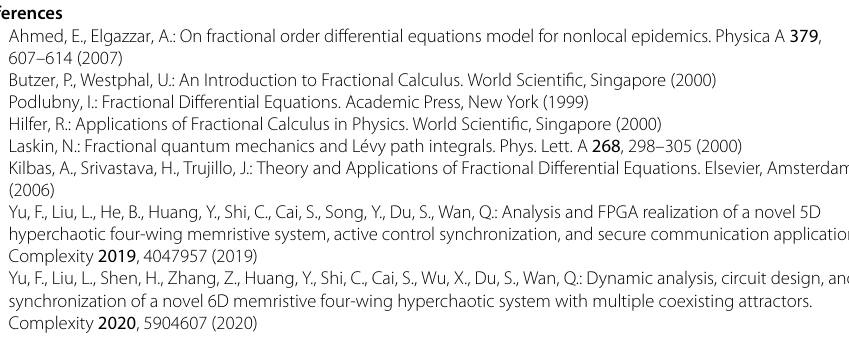
trollers, the updating law for the impulsive gains was provided. Examples 2 and 3 demon- strated the points well and implied that the adaptive impulsive controllers are universal for different